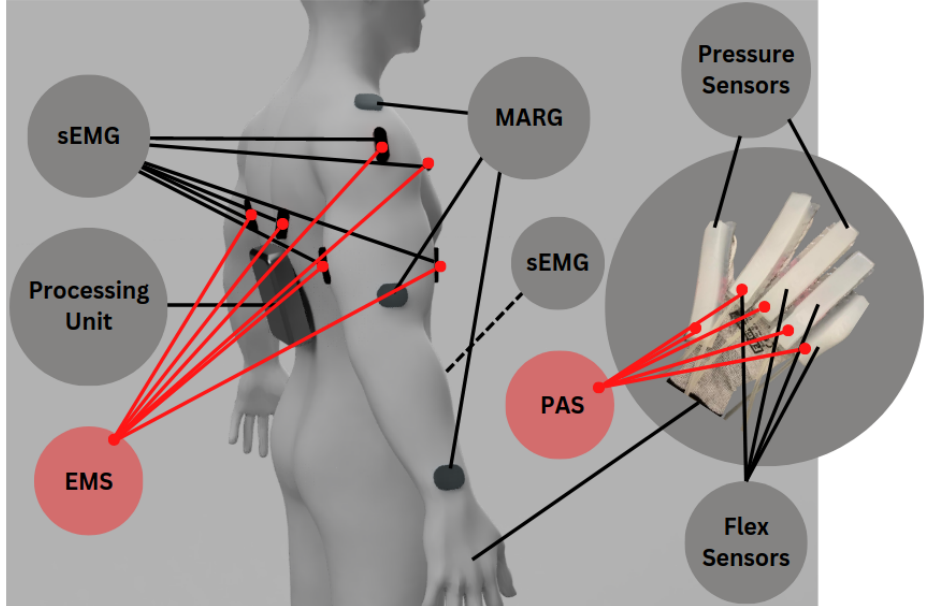
Figure 2. Concept image of the NeuroSuitUp platform sensor